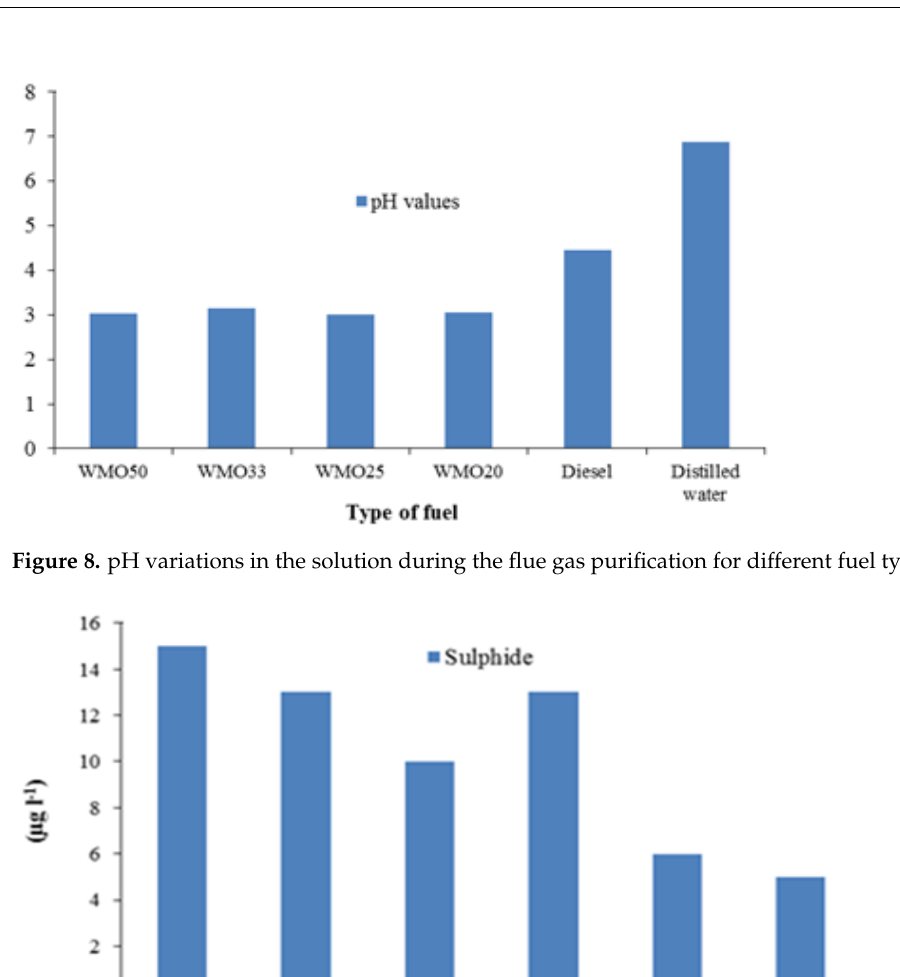
Figure 9. Content of sulphide in solution in flue gas flushing for different types of fuel.